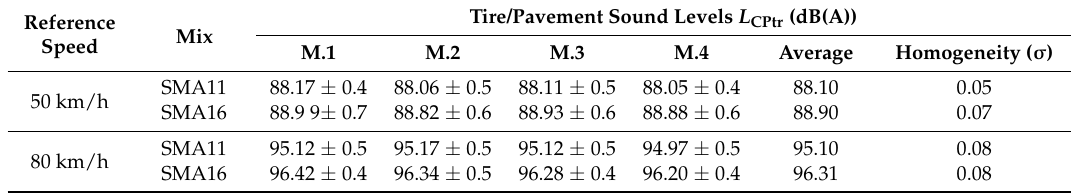
Table 2. Mean tire/pavement sound levels of each continuous measurement, average, and homogeneity from the four measurements. Values are not corrected by